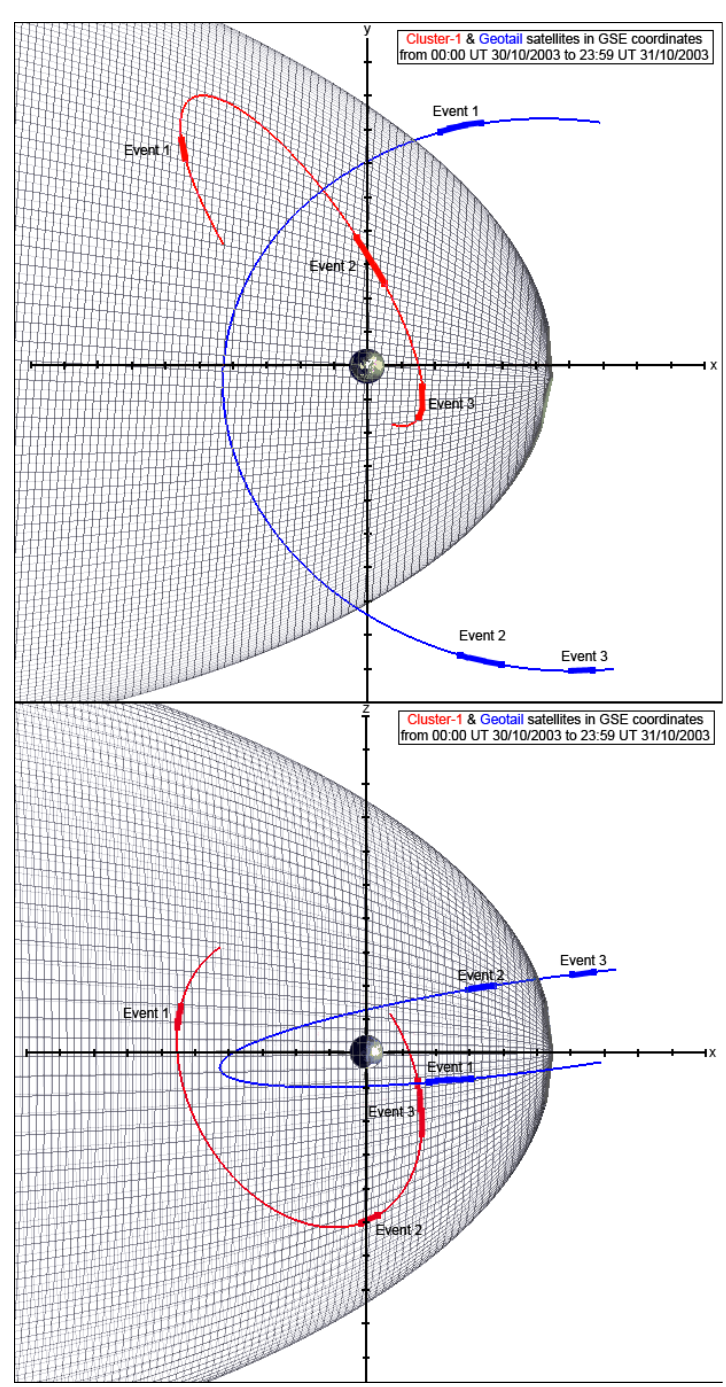
Fig. 2. The Cluster-1 and Geotail locations in GSE coordinates on the xy-plane (upper part) and on the xz-plane (lower part) for 30 and 31 October 2003. The three events discussed in this paper are also marked. (These plots are modified versions of the graphs derived by the Tool for Interactive Plotting, Sonification, and 3-D Orbit Display – TIPSOD provided by